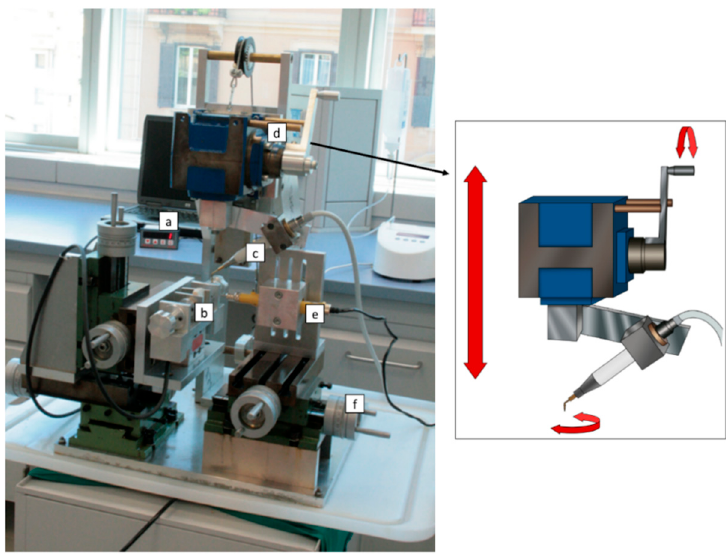
Figure 1. Mechanical positioning device used for the study with graphical representation of the transmission tool responsible for the handpiece movements. ( a ) Load cell, ( b ) bone sample, ( c ) piezoelectric handpiece, ( d ) transmission tool, ( e ) drill used to create the hole for the thermometer probe, and ( f ) micrometer screws to obtain three-dimensional movements of both the bone sample and the drill used to create the holes for the probe.